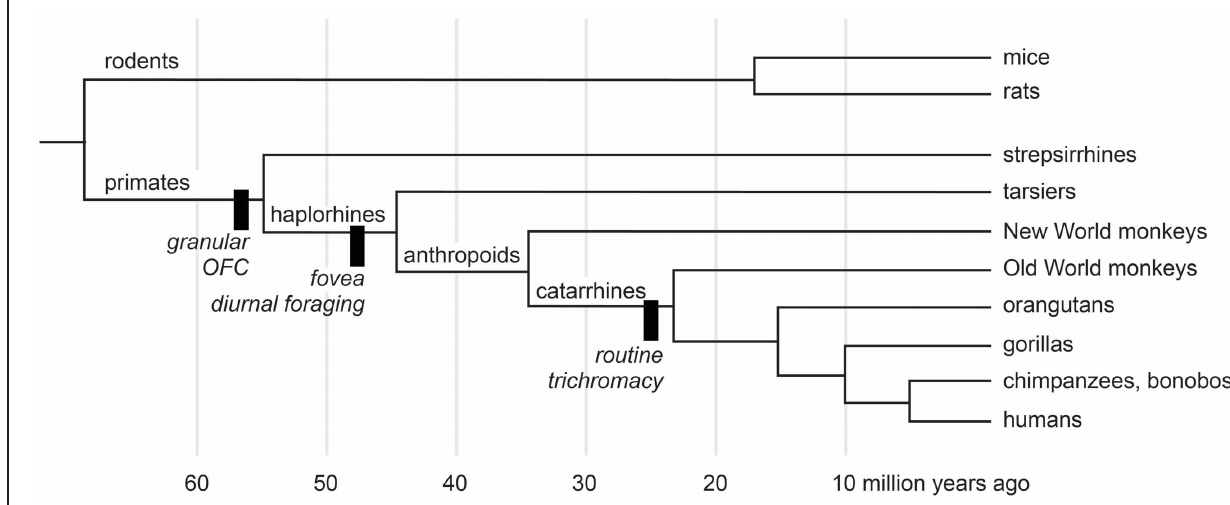
FIGURE 1 | A cladogram of primates and rodents on a linear time scale. The black bars show innovations of selected lineages. Adapted from Passingham and Wise (2012) and O’Leary et al. (2013).